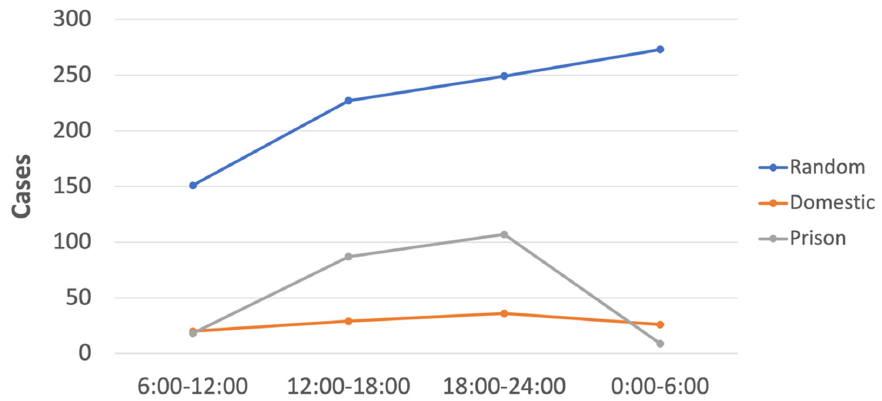
Figure 8. When did victims of assault-related TBI in Melbourne, Australia, present at the ED be-